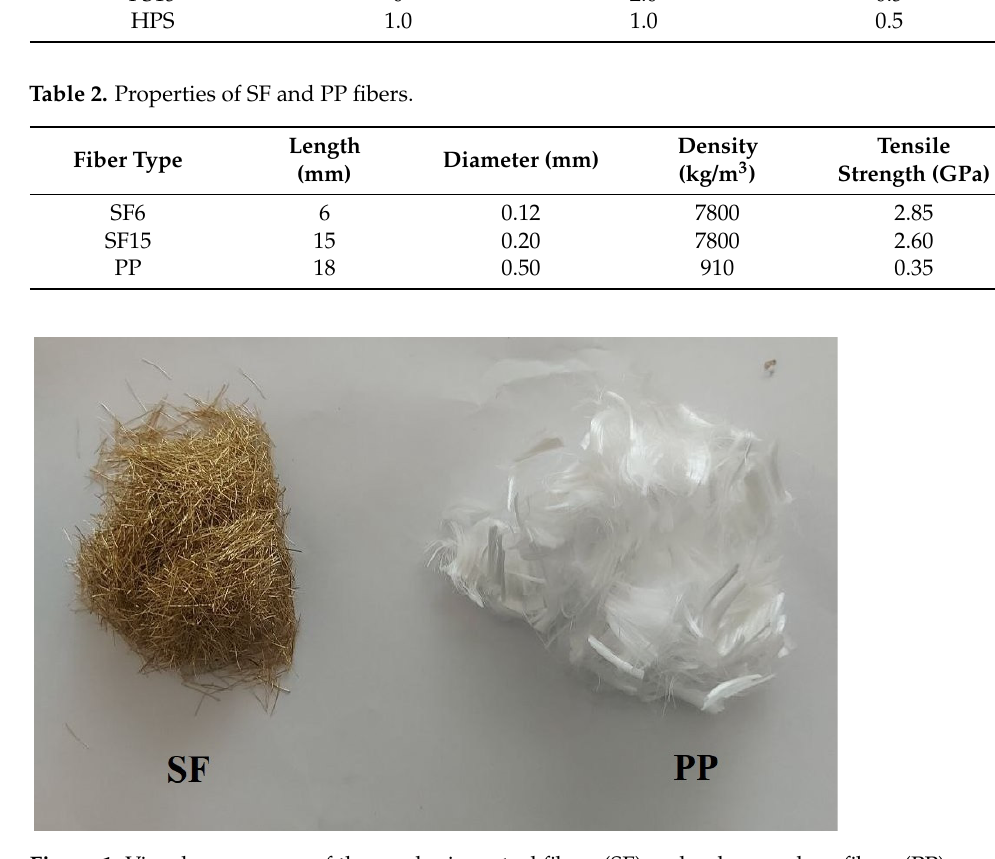
Table 2. Properties of SF and PP fibers.